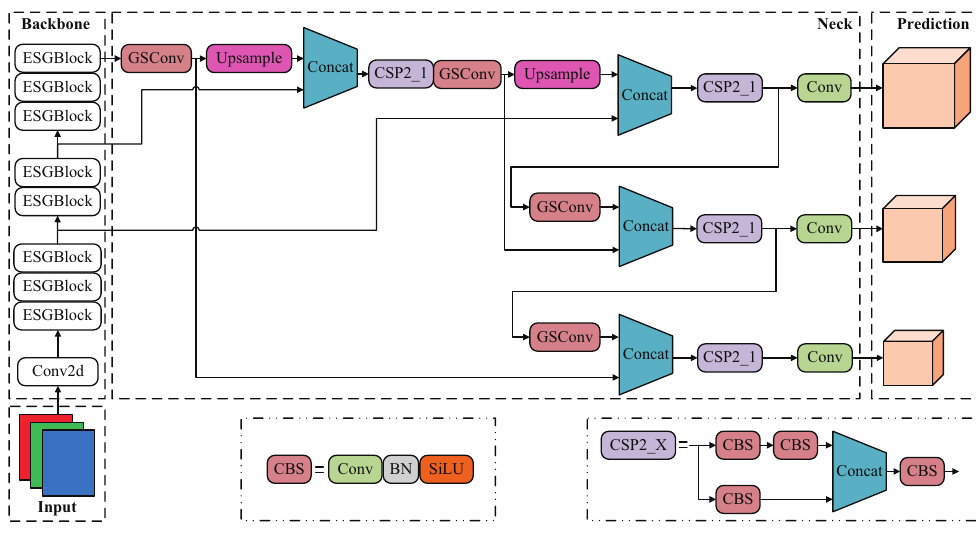
Figure 2. The overall structure of the SEDG-Yolov5 detection